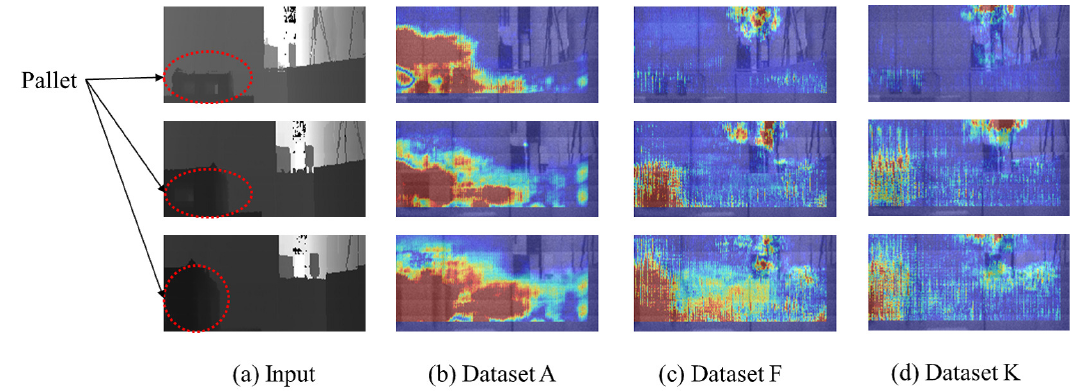
Figure 11. Results of important pixels of CNN-based localization in the scenario 1: ( a ) input data of SPAD LiDAR, ( b ) important pixels using the CNN trained by dataset A, ( c ) important pixels using the CNN trained by dataset F, and ( d ) important pixels using the CNN trained by dataset K.